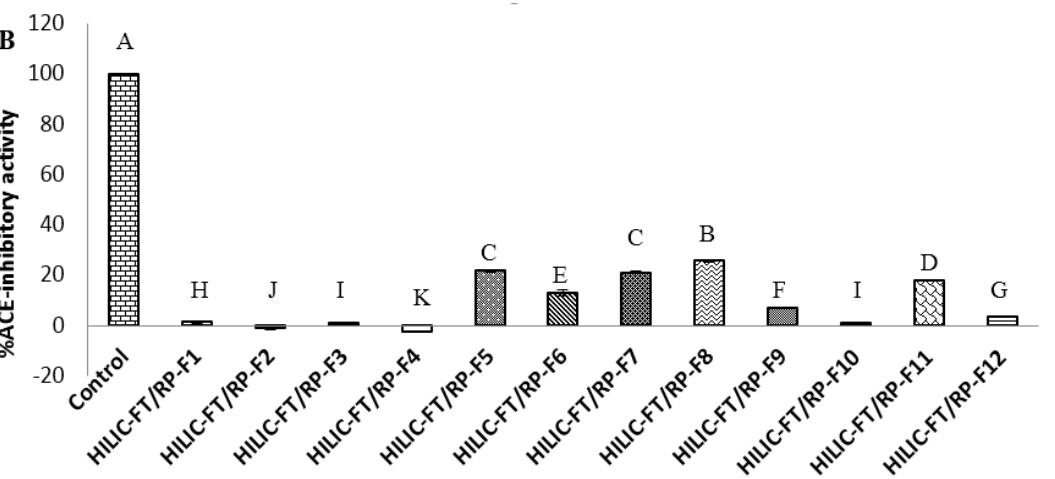
Figure 3. ( A ) RP-HPLC chromatogram of HILIC FT fraction, ( B ) ACE inhibitory activities of 12 fractions of HILIC FT separated using RP-HPLC. Means denoted by a different letter indicate significant differences between treatments ( p < 0.05).